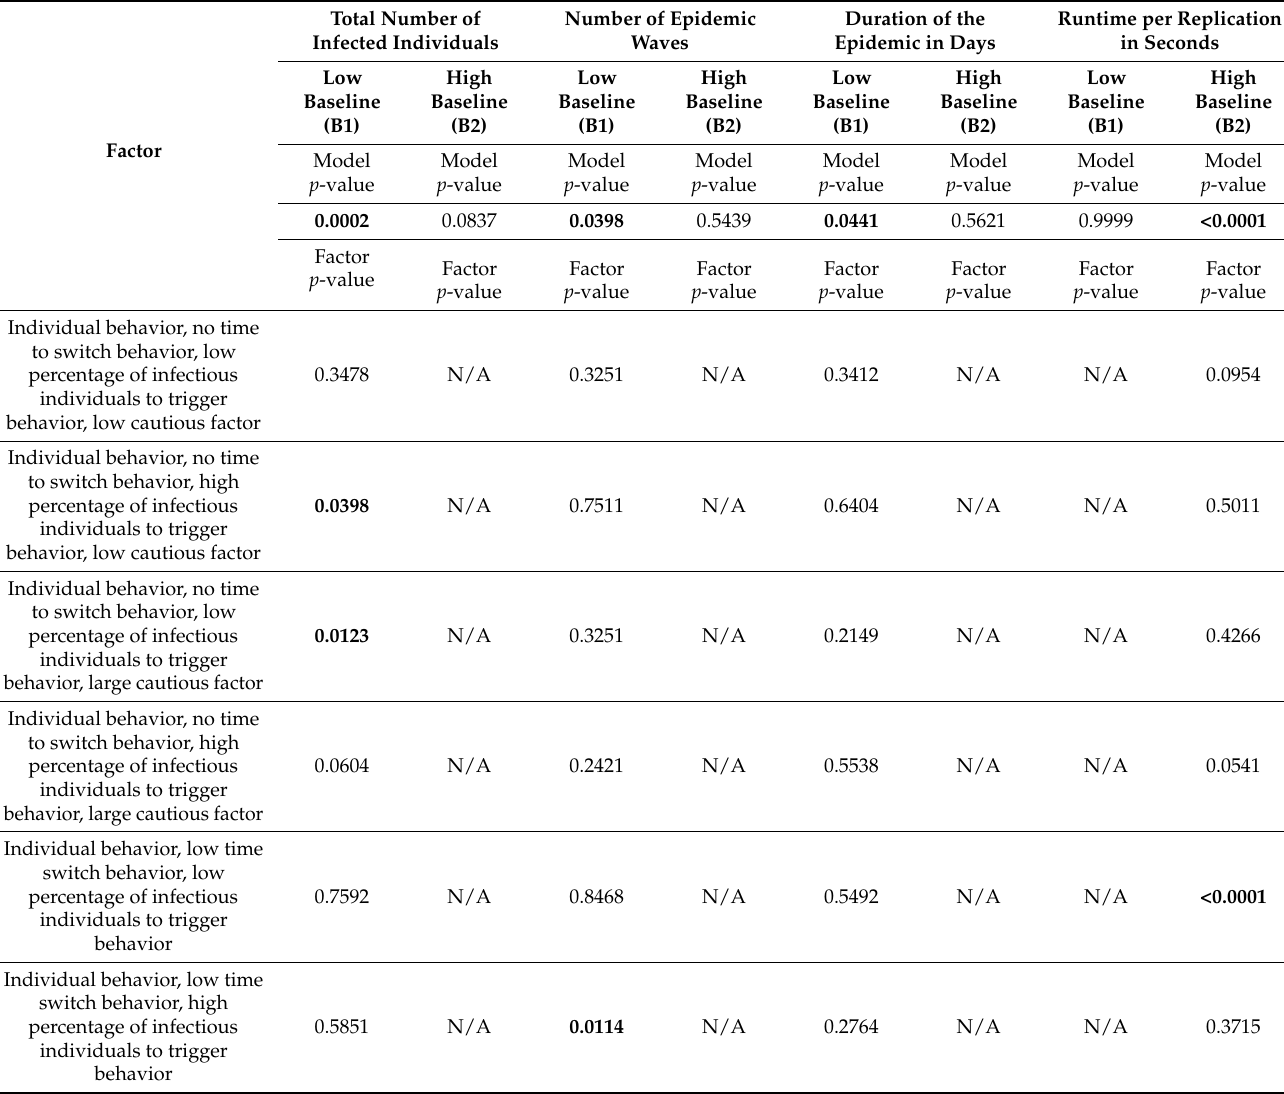
Table 11. ANOVA results for Model C (coupled human behavior and dengue spread model) per baseline level. Bold font denotes statistical significance at α -level of